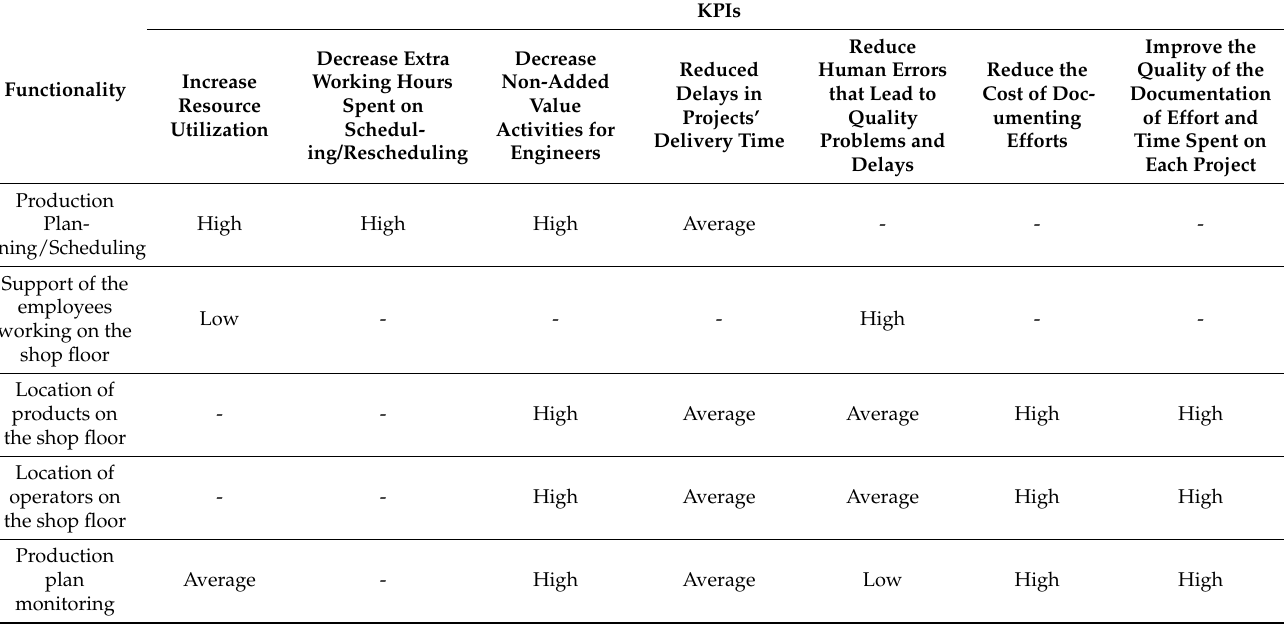
Table 2. The expected contribution of digital tools to the company’s